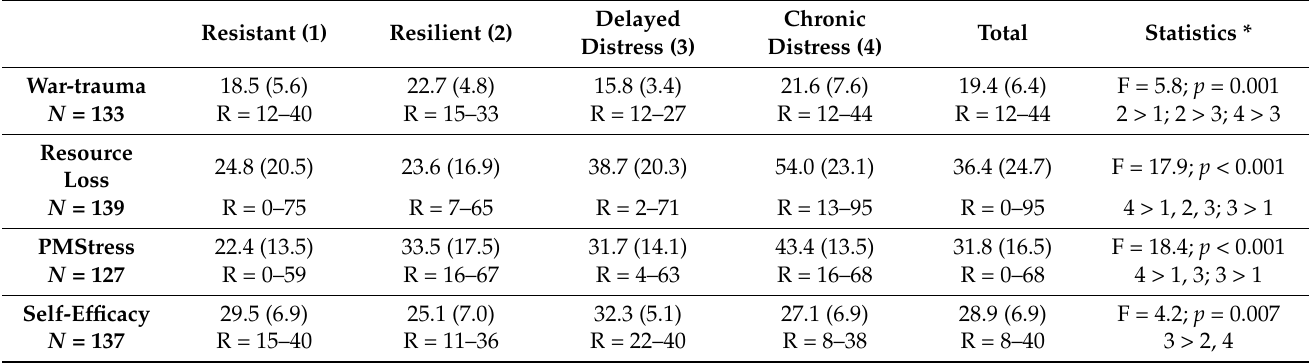
Table 5. ANOVA of predictor variables on trajectory.